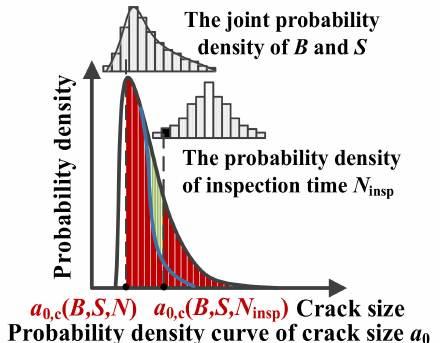
Figure 7. Detection domain through POD and inspection time.